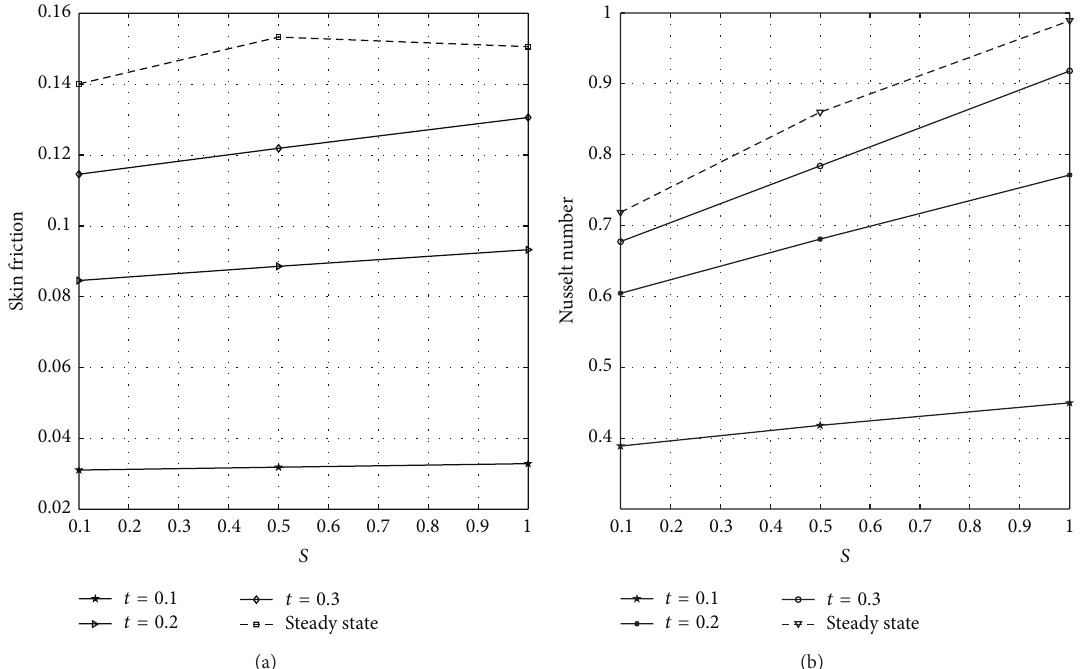
Figure 11: Variation of skin friction and Nusselt number with S and time ( 𝑡 ) at 𝑦 = 1 .